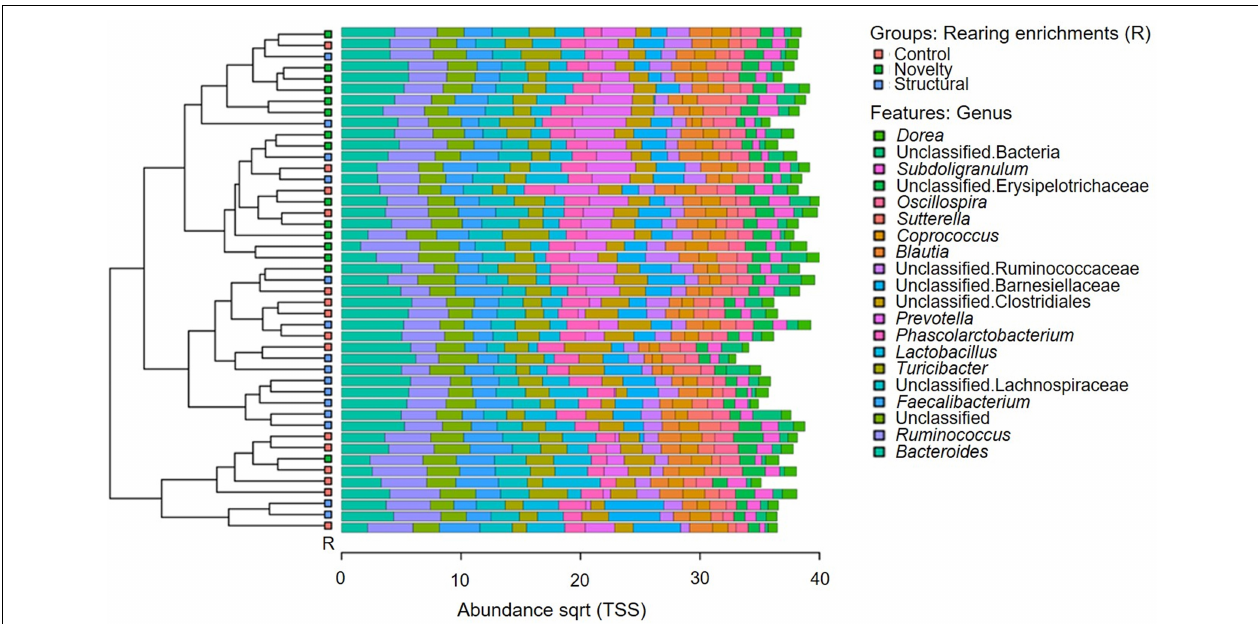
FIGURE 1 | Microbial community composition of pullets at 15 weeks of age from different rearing enrichments (control, novelty, structural). The top 20 abundant microbial genera are shown (clustered bar chart) in different enrichment groups of pullets.